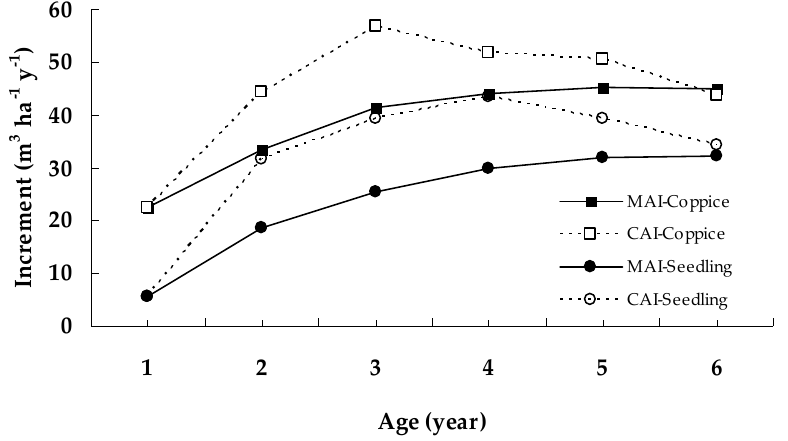
Figure 1. Mean annual increment (MAI) and current annual increment (CAI) of coppice and seedling stand of Eucalyptus pellita.